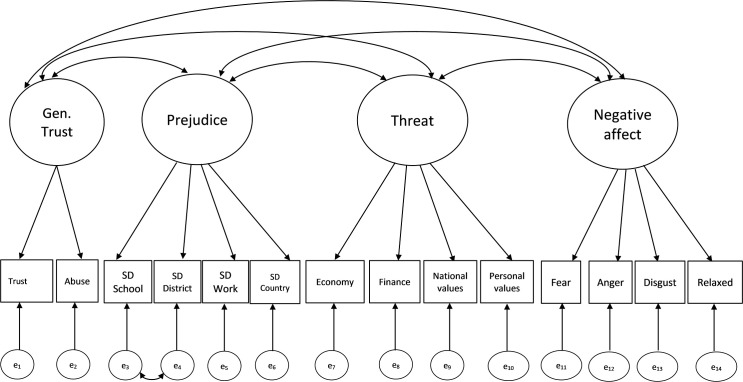
Graphical representation of the measurement model.Note: Model 2 in Table 2.